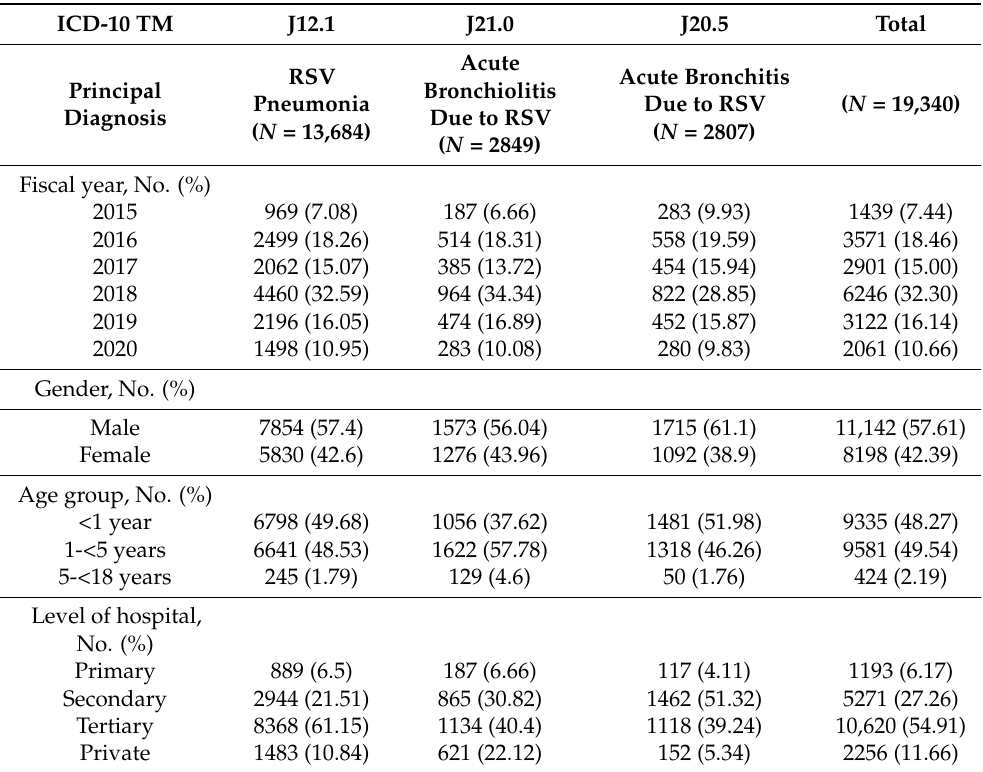
Table 1. The proportion of RSV LRTI in hospitalized children during the fiscal years 2015–2020.